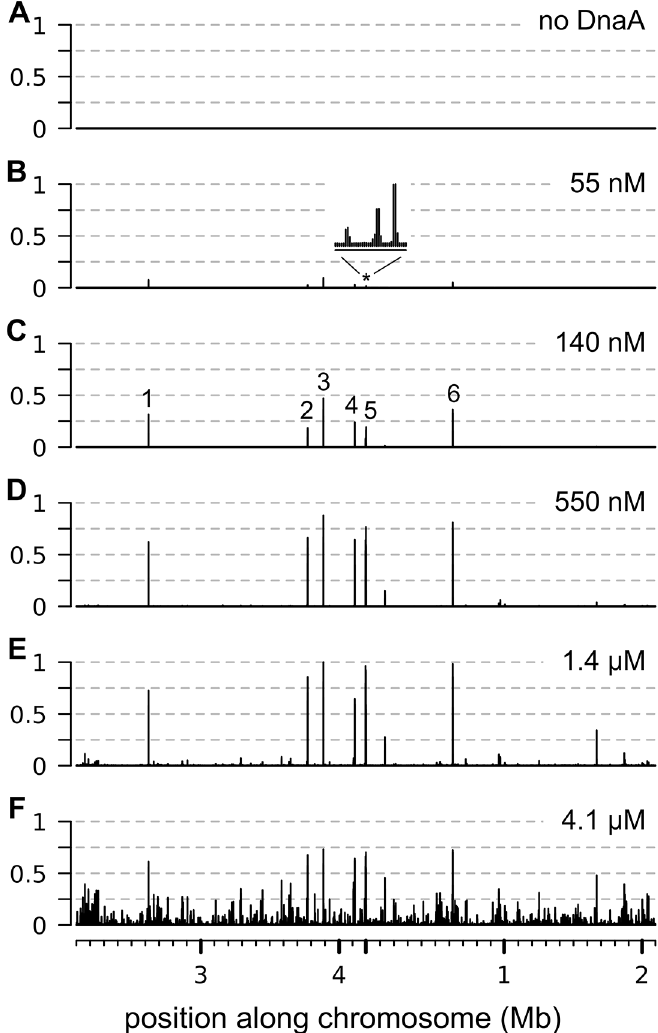
Fig 1. Binding of ATP-DnaA-his to genomic DNA in vitro . The relative amount of binding by ATP-DnaA- his is plotted on the y-axis (normalized so that maximum binding has an amplitude of 1) versus the position along the chromosome on the x-axis. The amount of binding was determined by sequence analysis of the DNA recovered in each binding reaction. Binding data is presented in 200 nucleotide bins, with the maximum binding amplitude in each bin drawn. The 4.2 mb circular chromosome is depicted linearly such that the origin of replication is near the middle of the x-axis. The concentration of ATP-DnaA-his in each binding reaction was (A) no DnaA; (B) 55 nM; (C) 140 nM; (D) 550 nM; (E) 1.4 μ M; (F) 4.1 μ M. The major peaks are numbered (C) , and correspond to the following nearby loci: (1) sda ; (2) ywlC ; (3) ywc I; (4) yydA ; (5) consists of 3 adjacent peaks ( trmE , dnaA , and between dnaA and dnaN ) that are not resolved at this scale; (6) gcp / ydiF . The inset in panel B above the asterisk corresponds to a 7 kb region that contains the trmE , dnaA , and dnaA/N binding